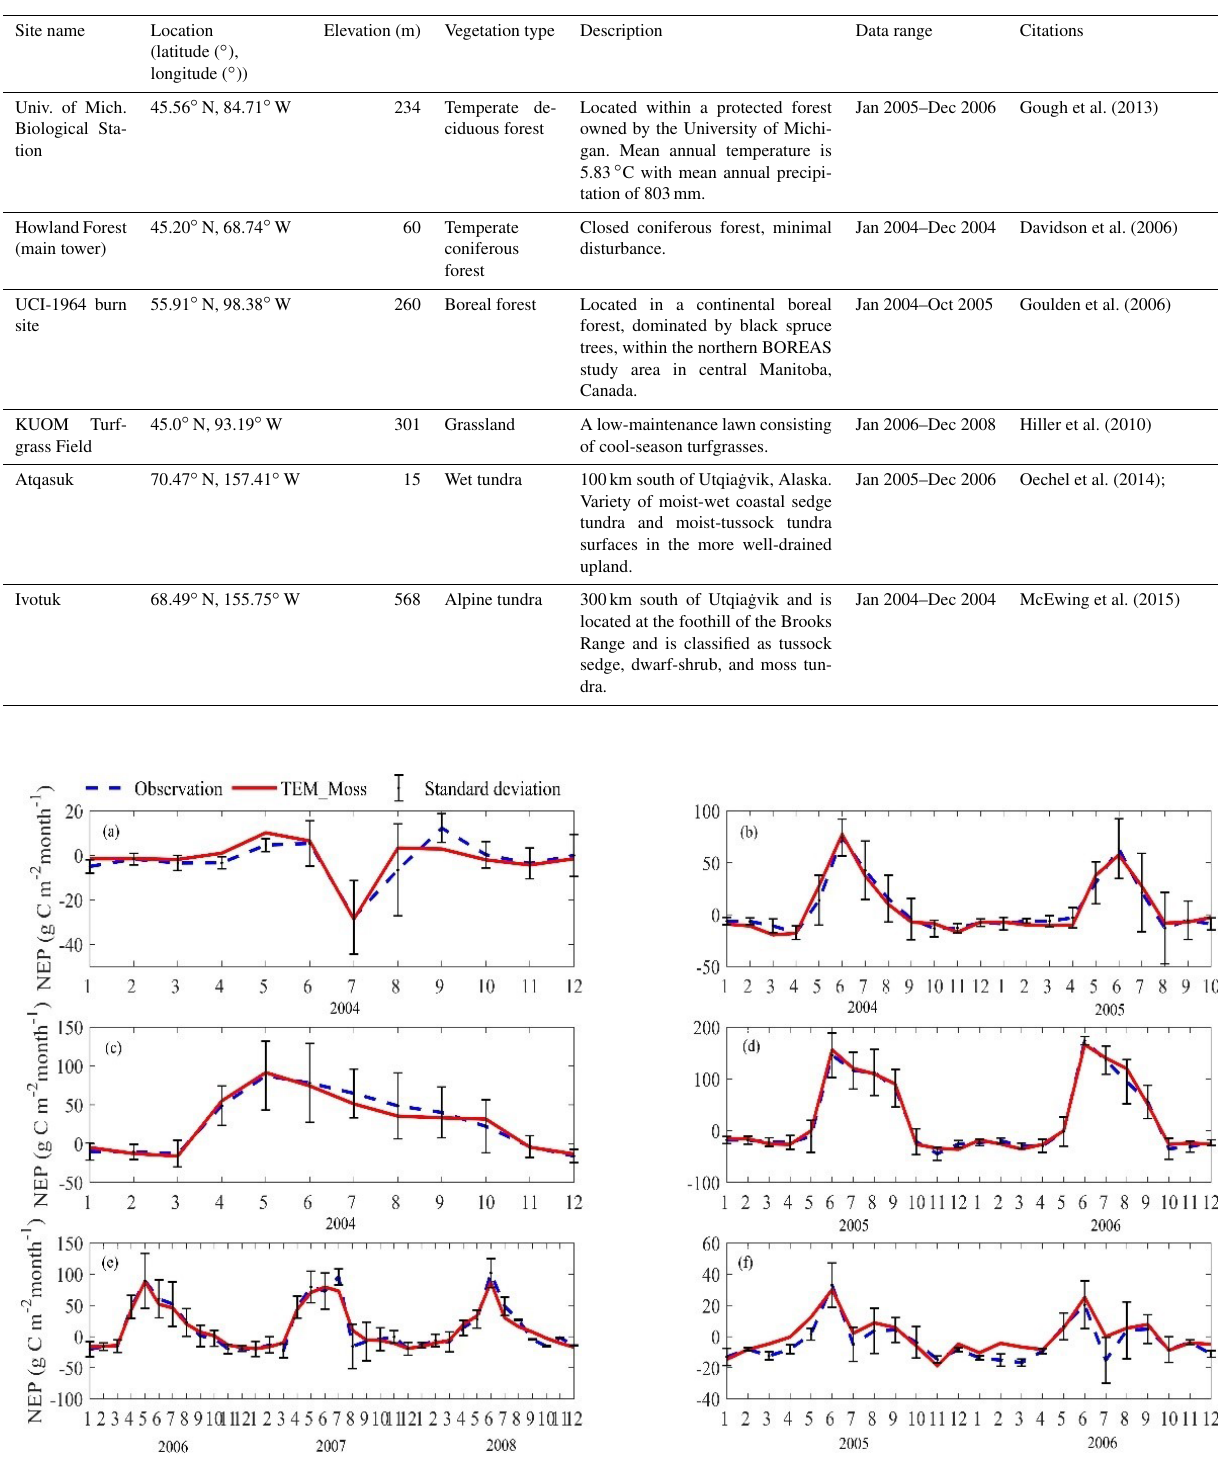
Figure 3. Comparison between observed and simulated NEP (gCm − 2 month − 1 ) at (a) Ivotuk (alpine tundra), (b) UCI-1964 burn site (boreal forest), (c) Howland Forest (temperate coniferous forest), (d) Univ. of Mich. Biological Station (temperate deciduous forest), (e) KUOM Turfgrass Field (grassland), and (f) Atqasuk (wet tundra). Error bars represent standard errors among daily data in 1